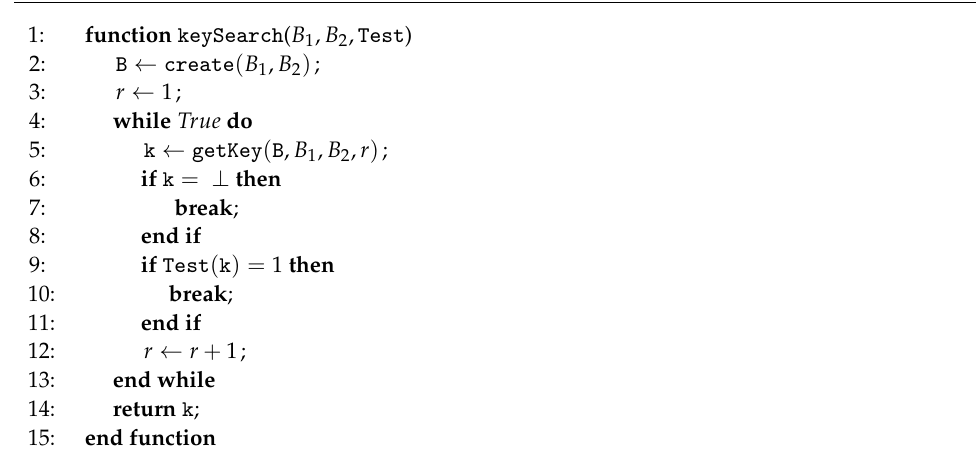
Algorithm 9 enumerates and tests all full key candidates with weight in the interval [ B 1 , B 2 )